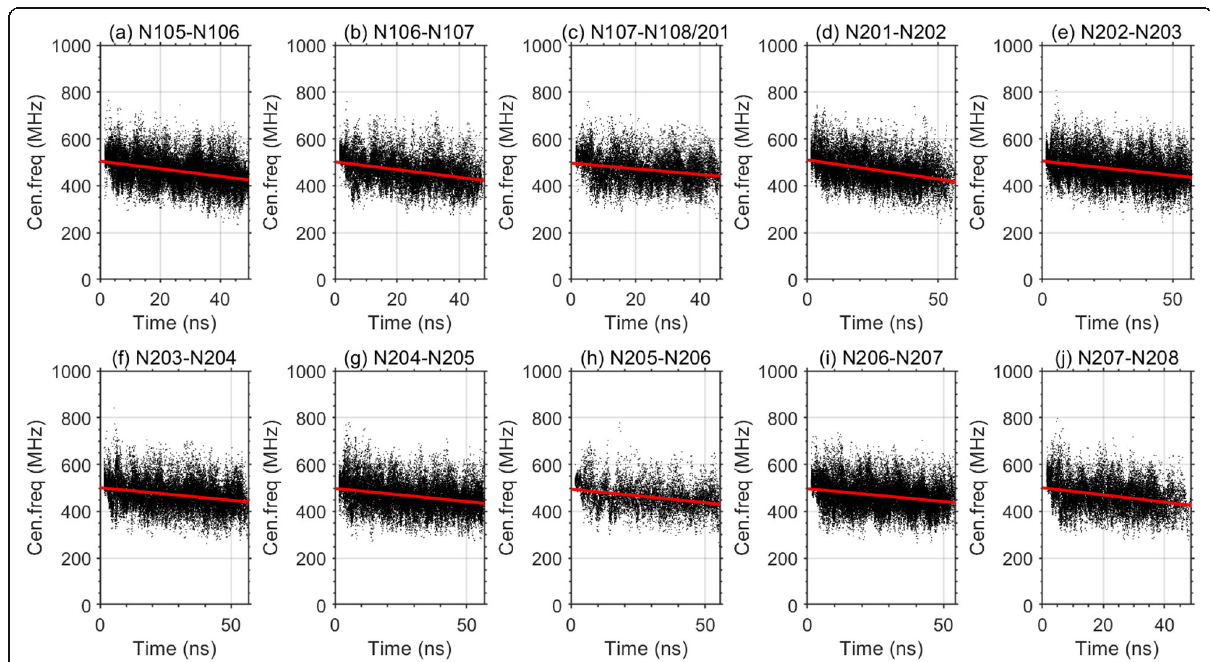
Fig. 4 The relationship between the centroid frequency of the received signal ( f r ) and the time-delay for each segment of the LPR data. The data segments ( a – j ) are divided according to the adjacent navigation points from N105 to N208. The red lines are the best-fit between f r and τ using the least square method. The slopes of the best-fit lines are the drift rate of f r with τ